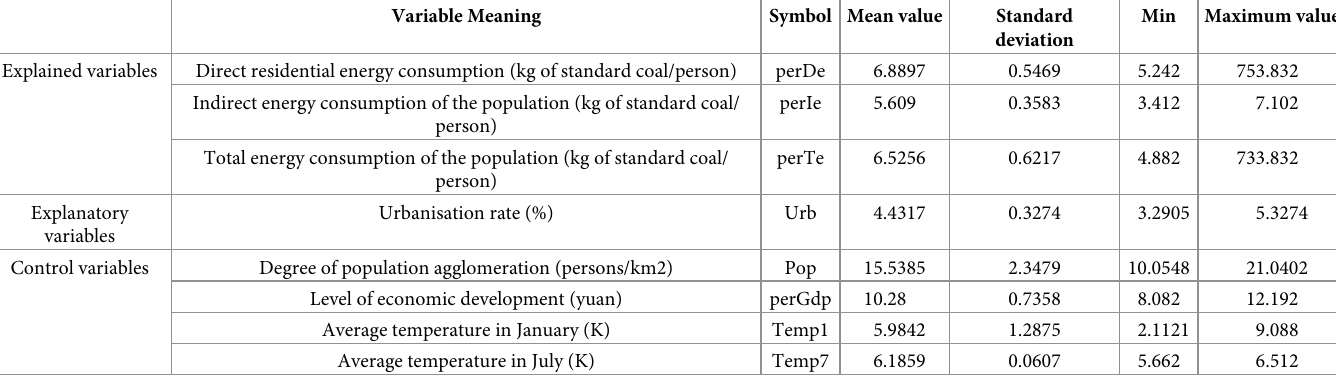
Table 2. Model-related variable settings and descriptive statistical